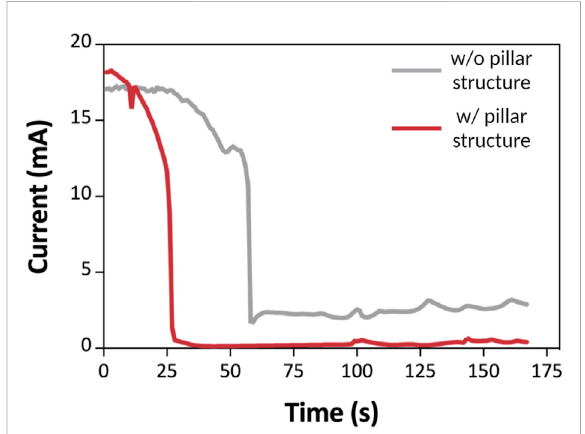
FIGURE 3 Current-voltage curves . I-V curve of the 3DP 2 without (gray line) and with (red line) pillar-structured channel. There are three regions: In the ohmic region, the current increases as the voltage increase in a linear relationship. In limiting regions, the current is maintained at a certain level. At last, in the over-limiting region, the current increases innon-linear form, and thedepletion zone